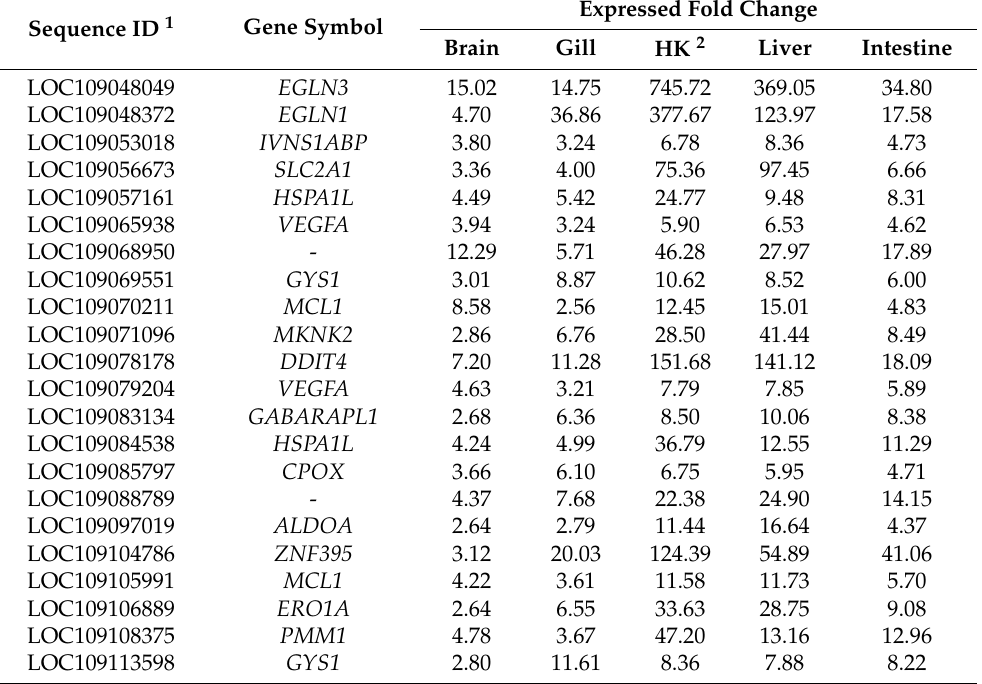
(Table S2: upregulated genes, and Table S3: downregulated genes). From the